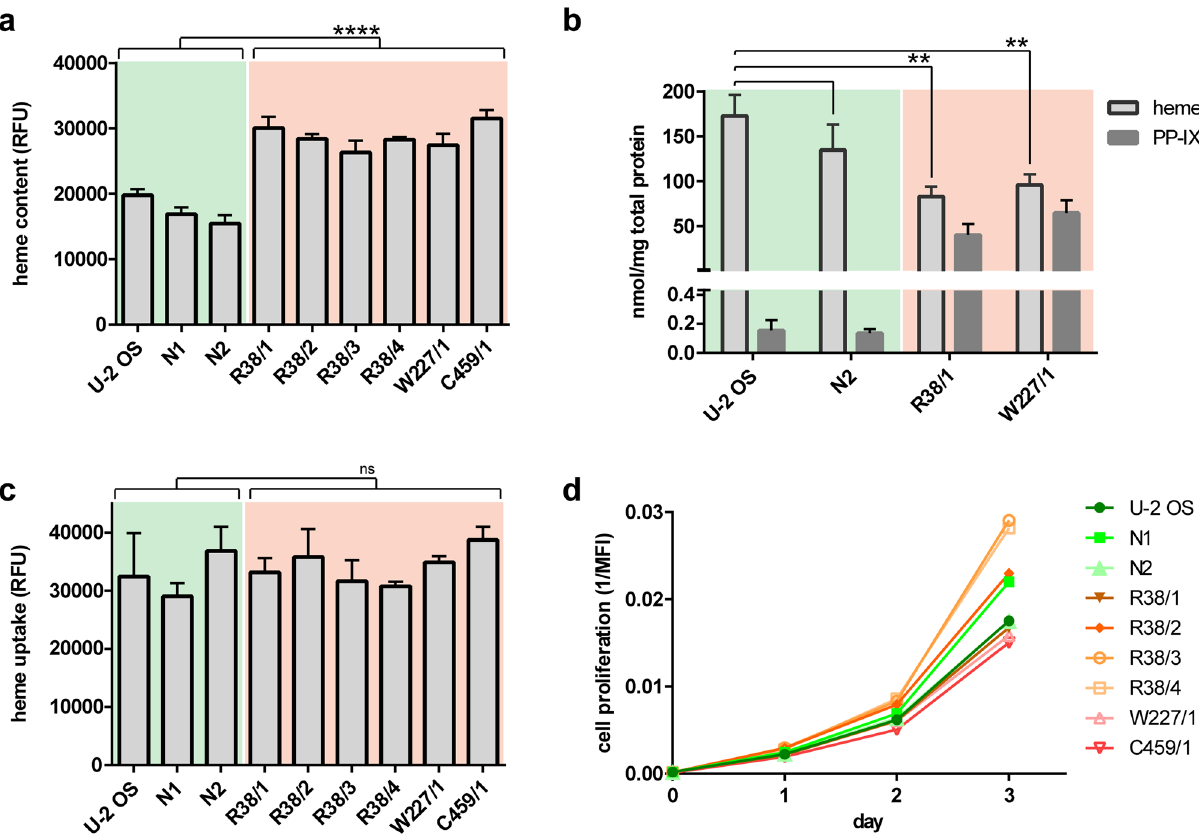
Figure 2. Characterization of PPO-KO cell lines. ( a ) Content of intracellular heme determined by iron- chelation assay. Statistical significance was calculated by unpaired parametric t-test with Welch’s correction and assigned by **** (P < 0.0001). Data represent mean (± S.D.); n = 3. Control samples and PPO-KO clones are highlighted by green and orange background, respectively. ( b ) Content of intracellular protoporphyrinogen/ protoporphyrin IX and heme determined by RP-HPLC. Statistical significance was calculated by one-way ANOVA and assigned by ** (P < 0.01). Data represent mean (± S.D.); n = 3. ( c ) Uptake of Zn-protoporphyrin (Zn-PP; fluorescent heme analog) by studied cell lines. Fluorescence of intracellular Zn-PP was determined following 3-h incubation of cells with 60 µM Zn-PP. Statistical significance was calculated by unpaired parametric t-test with Welch’s correction and assigned by ns (non-significant; P > 0.05). Data represent mean (± S.D.); n = 2. ( d ) Proliferation rate of studied cells was determined by quantifying intracellular